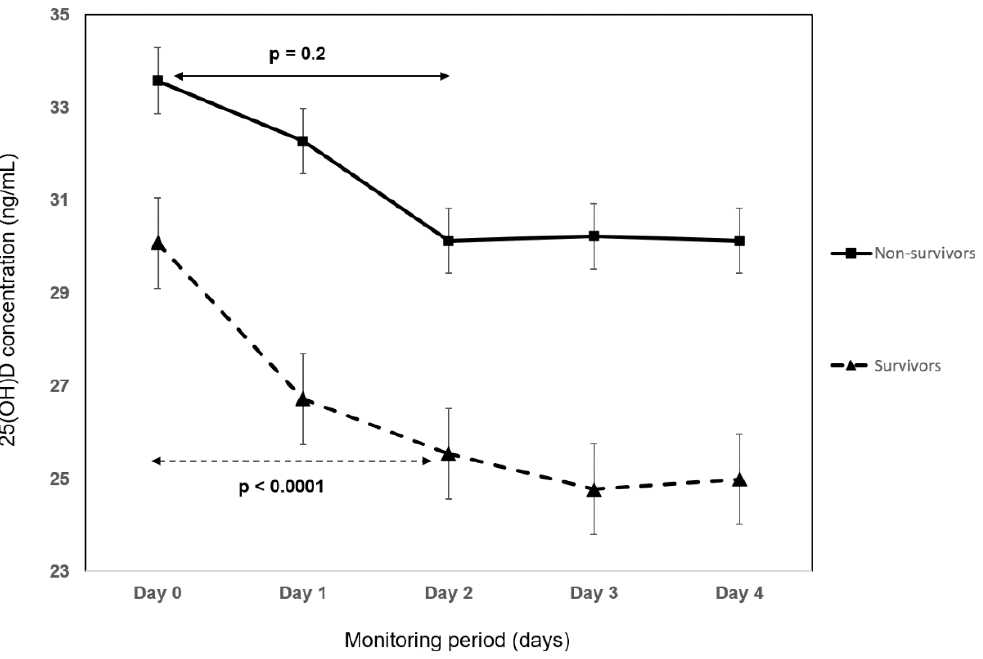
Figure 4. The kinetics of 25-hydroxyvitamin D (25[OH]D) concentration during hospitalization between survivors and non-survivors. p -values of the changes during the first 48 h are displayed.